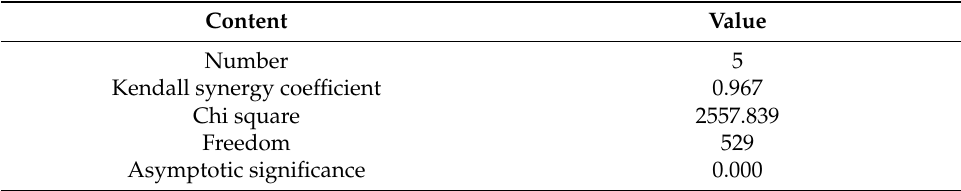
Table 2. Consistency test